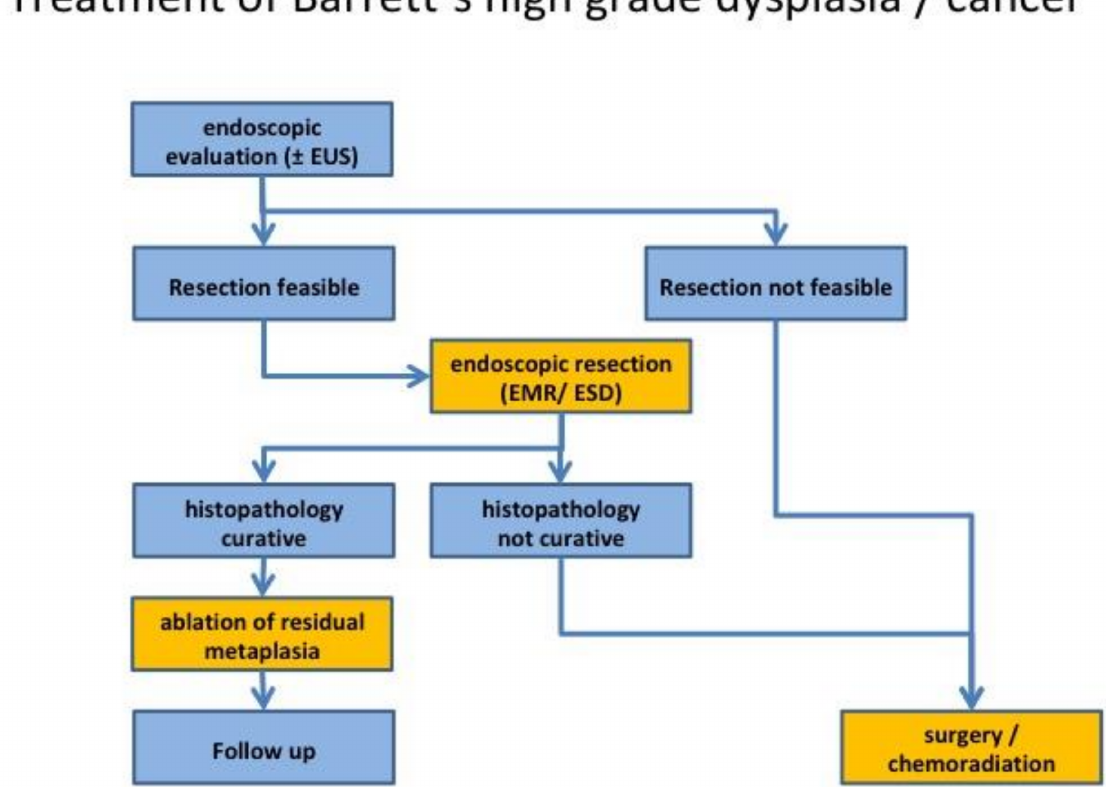
Figure 3. Proposed treatment algorithm according to current guidelines [30]. Evaluation may include endoscopic ultrasound to assess possible lymph node metastasis. Criteria for curative resection are listed in Table 2. EUS, endoscopic ultrasound; EMR, endoscopic mucosal resection; ESD, endoscopic submucosal